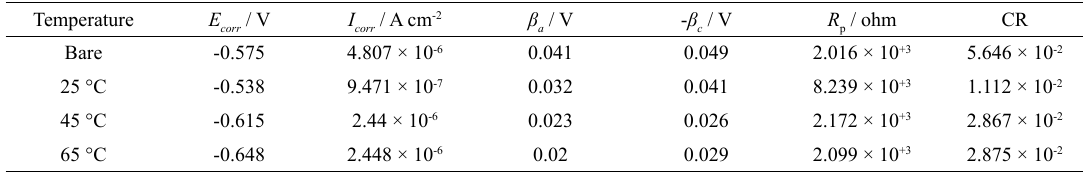
Table 3. Potentiodynamic polarization parameters of different operating temperature for the cerium coatings in 3.5 wt. % NaCl solution. Coatings were prepared by 60 s immersion time in cerium solution. Temperature